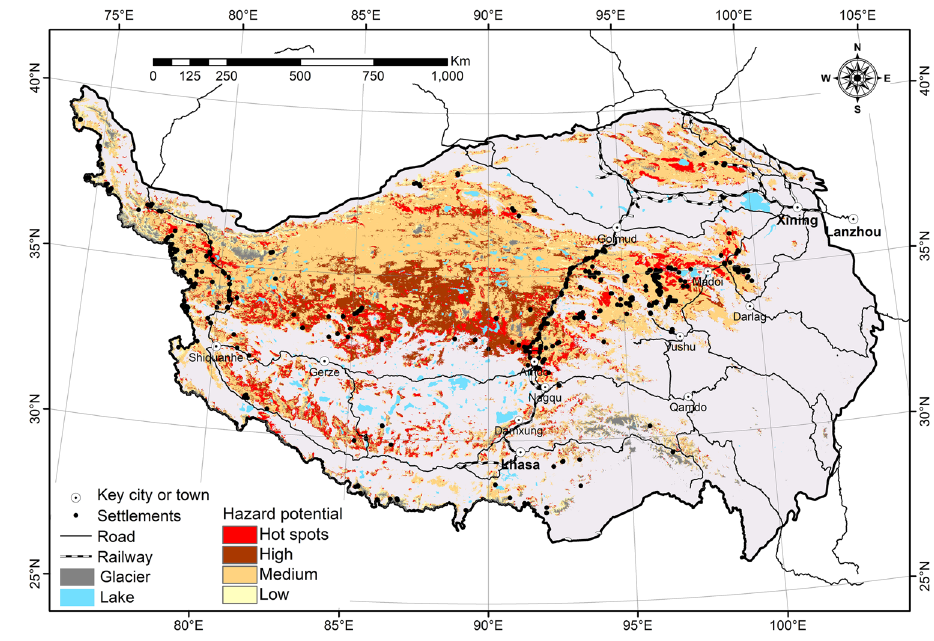
Fig. 1 The distribution of infrastructure hazard zones by 2050 (2041-2060) under the historical scenario (SSP245). The hazard levels (high, medium and low) of permafrost degradation for infrastructure were derived from fi ve hazard indices (thermal index, settlement index, bearing capacity index, risk zone index, and expert-based index) using a majority vote procedure. Hotspot areas indicate that at least four indices showed high hazard levels. Infrastructure, including backbone road networks, railways, and buildings, is shown, while the distribution of power lines is generally consistent with the road network. Thus, the infrastructure pattern over the Qinghai-Tibet Plateau mainly includes three regions, i.e., the western engineering corridor (north of Shiquanhe), the central Qinghai-Tibet engineering corridor from Golmud to Lhasa, and the eastern corridor around Madoi. The infrastructure distribution data extracts from OpenStreetMap data and are licensed under CC BY-SA 2.0 (https://creativecommons.org/licenses/by-sa/2.0/). Glacier and lake extent data obtained from National Tibetan Plateau Data Center (10.3972/glacier.001.2013.db) and are licensed under CC BY 4.0